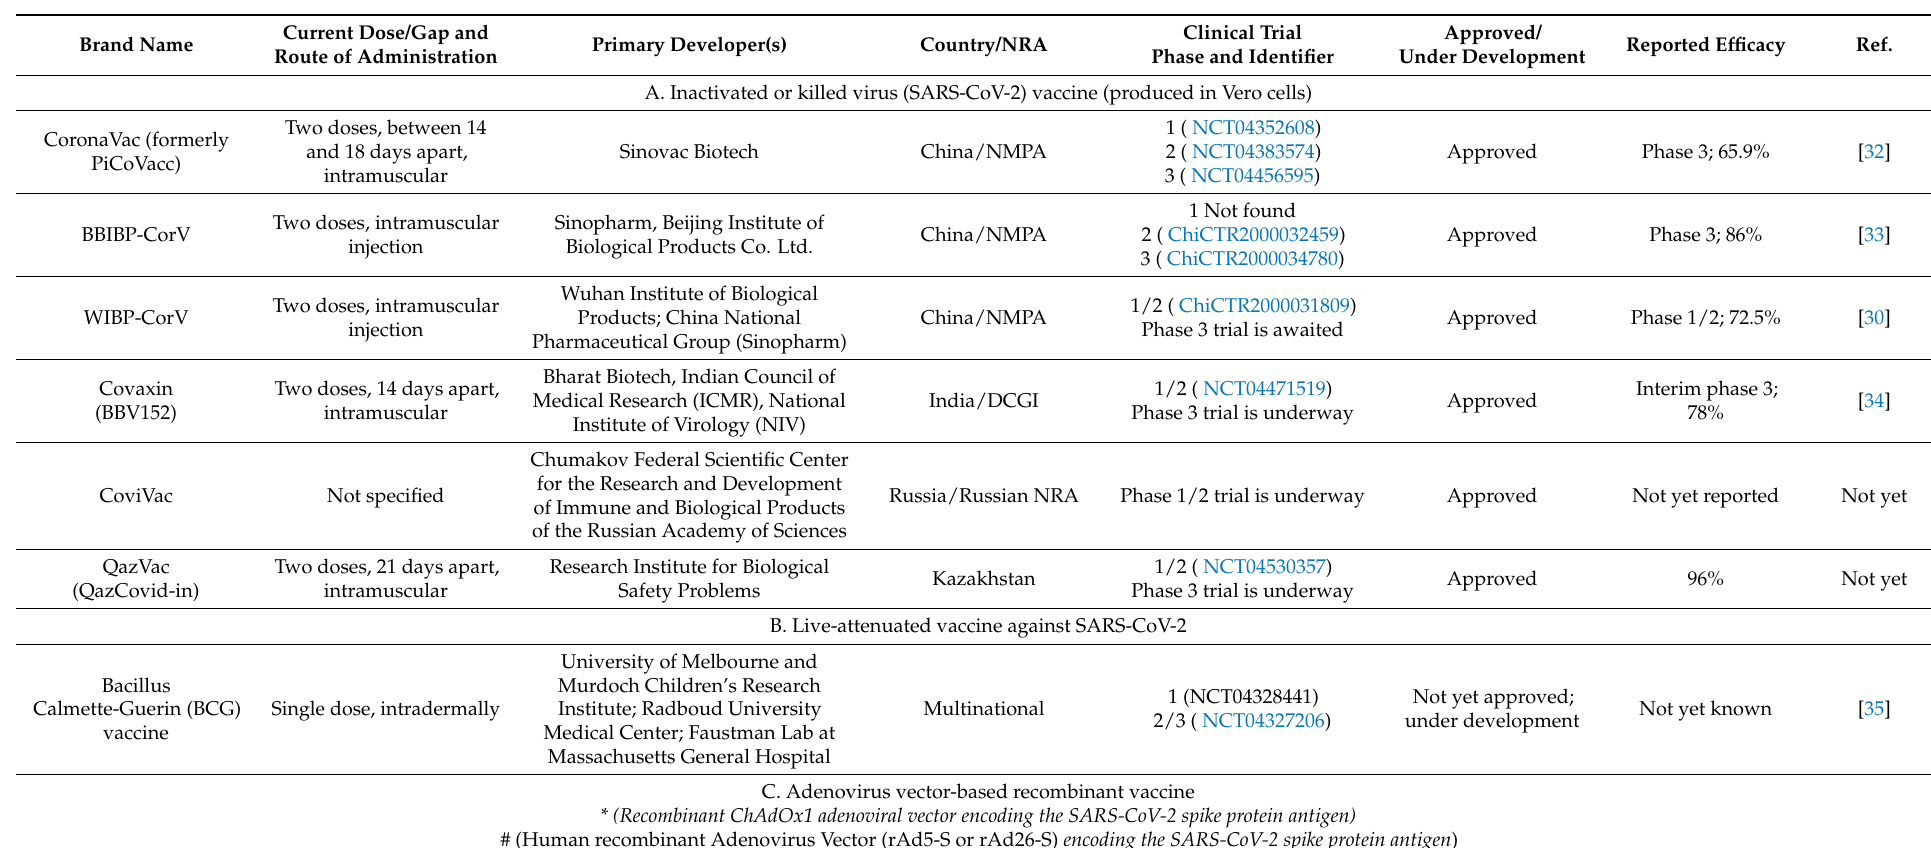
Table 1. Important vaccines authorized/under development for